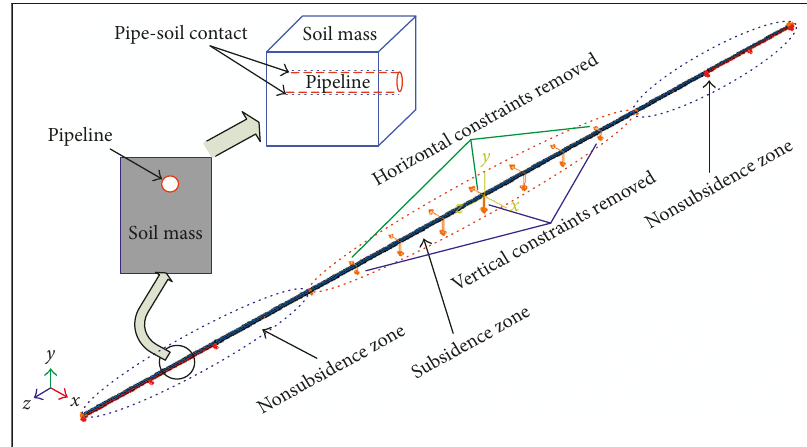
Figure 14: Simulation model and displacement